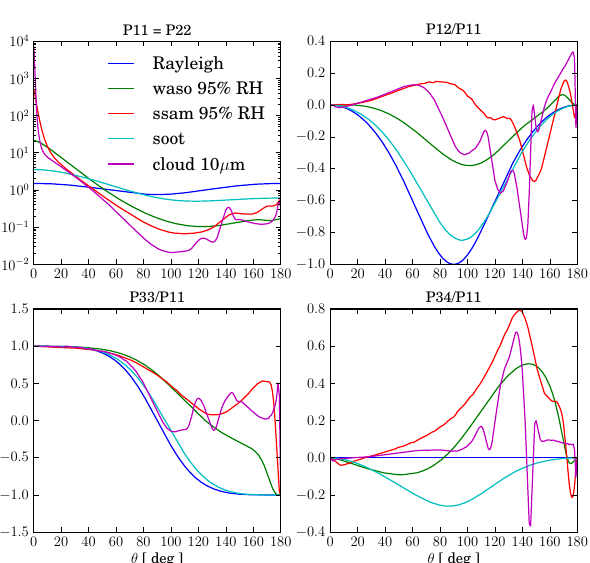
Figure 3. Phase matrix elements for the basic OPAC aerosol types “water soluble” ( waso ), “sea salt accumulated mode” ( ssam ), and soot , for a water cloud with a droplet effective radius of 10µm, and for Rayleigh scattering (with δ = 0) at a wavelength of 350nm. θ is the scattering angle, i.e. the angle between incoming and scat- tered